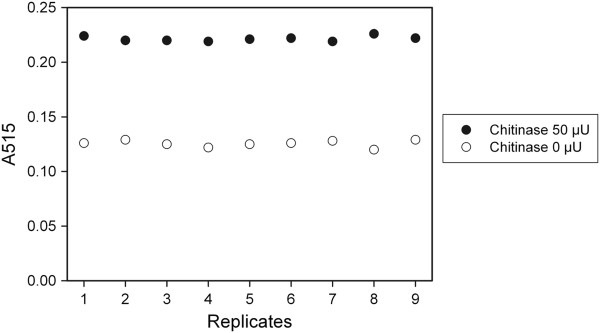
Reproducibility of the ChitO-based assay with chitinase. Absorbance values of the ChitO-based assay from nine replicates of colloidal chitin treated for 1 hour with 50 μU of chitinase from Streptomyces griseus were plotted against nine replicates of untreated colloidal chitin under the same assay conditions. ChitO, chito-oligosaccharide oxidase.